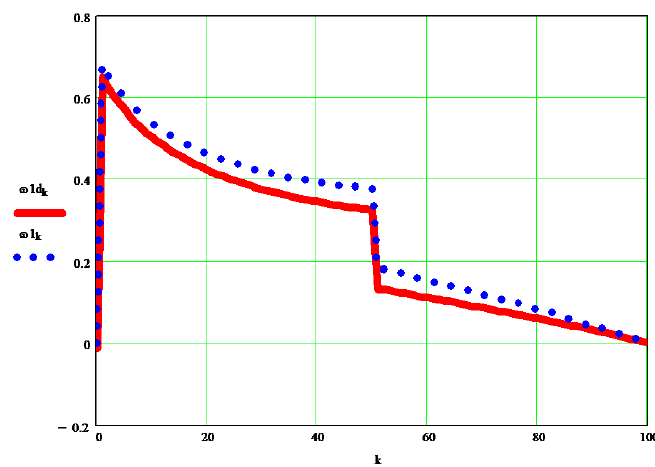
Figure 10. The differences between angular dynamic velocity w 1 d and the angular kinematic velocity w 1.